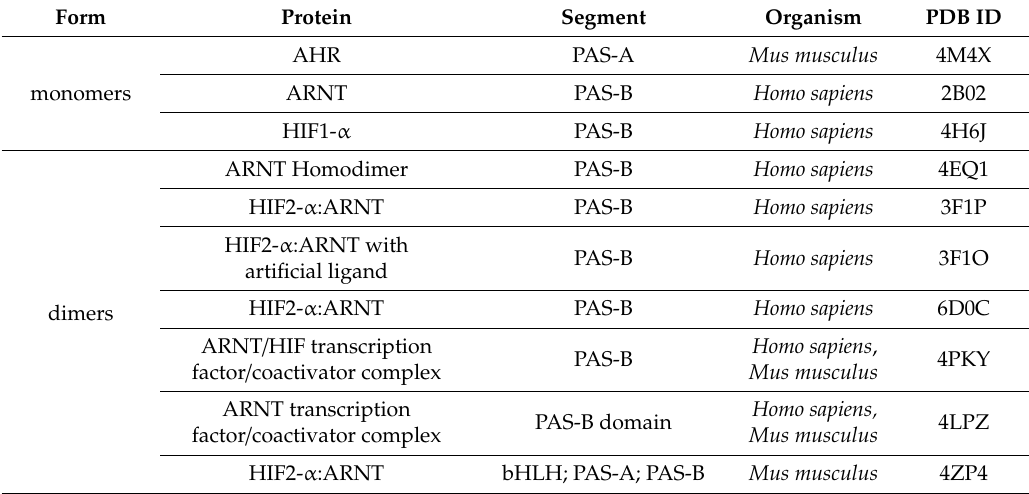
Table 3. bHLH–PAS protein structures deposited in the PDB obtained with X-ray di ff raction. Form